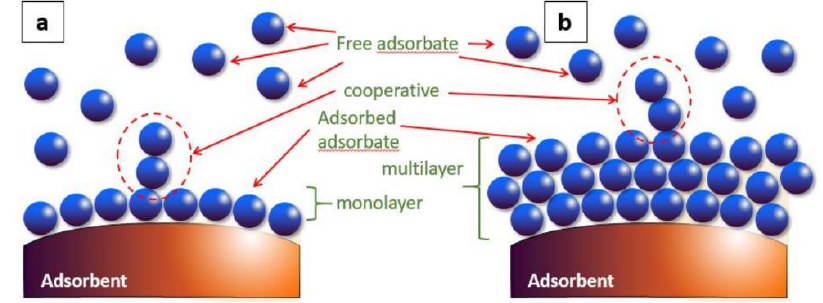
Table 1. Difference between physical adsorption and chemical adsorption.